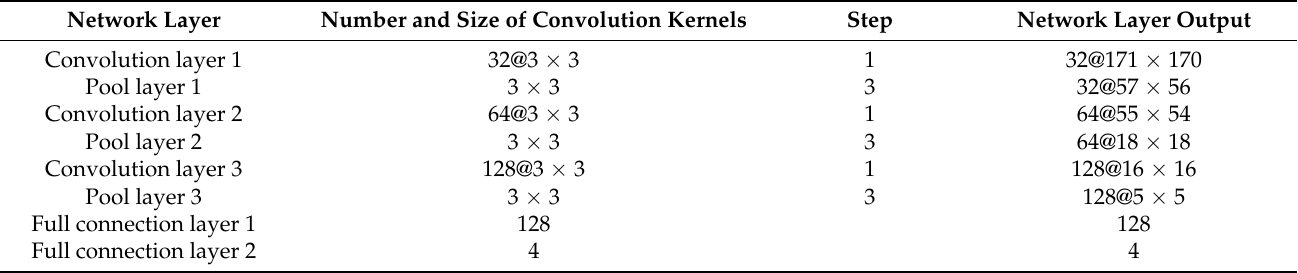
Table 1. CNN Model